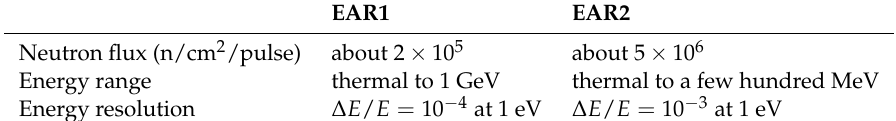
Table 1. Features of the n_TOF neutron beam in the two available experimental areas. The beam repetition rate is 1.2 s minimum (as to avoid neutron wrap-around in TOF measurements). Data extracted from References [6,9,10].